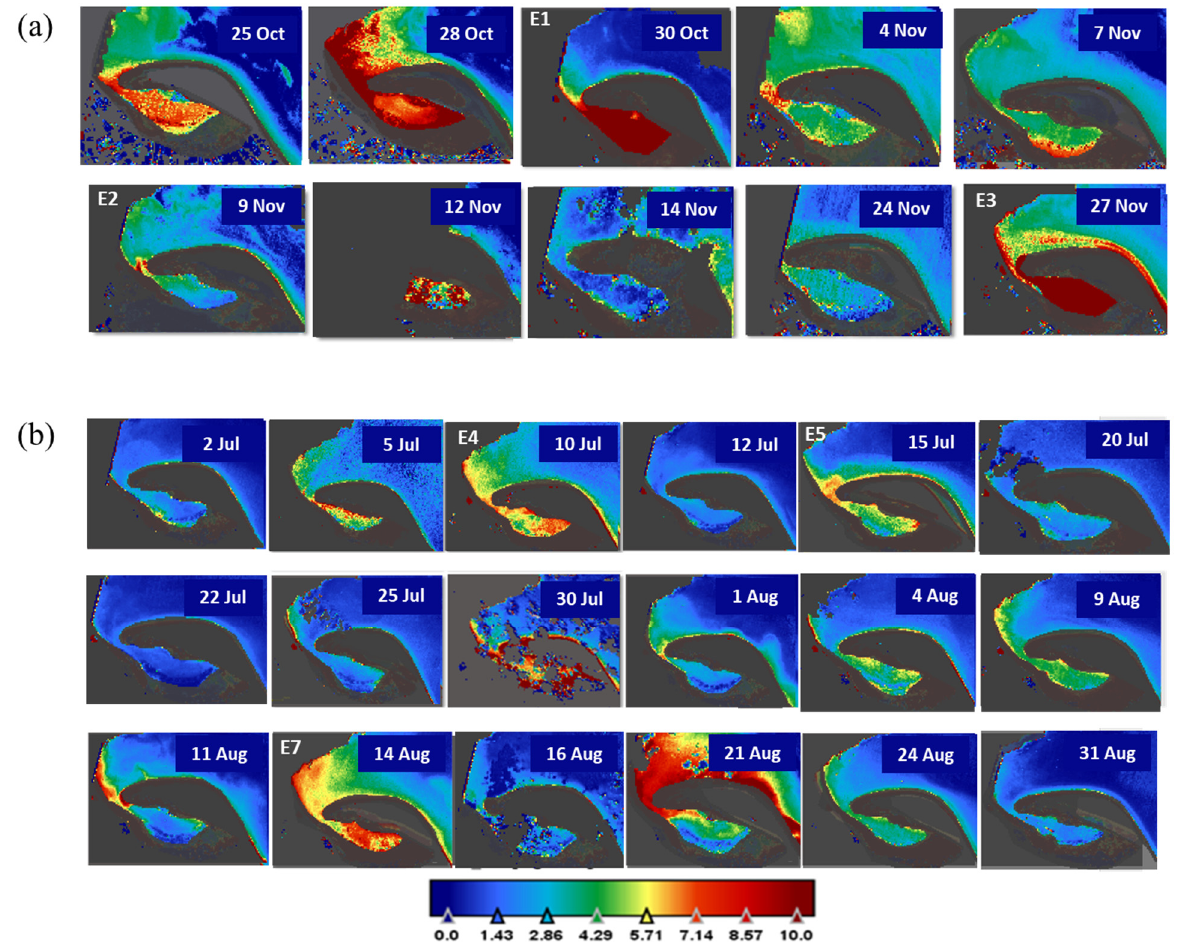
Figure 4. Sentinel-2 images during FANGAR-III ( a ) and during FANGAR-IV ( b ). The wind episodes are marked in each corresponding image with white letters. Episodes L1 and E6 did not match with any satellite image, so they are not represented in the figure.